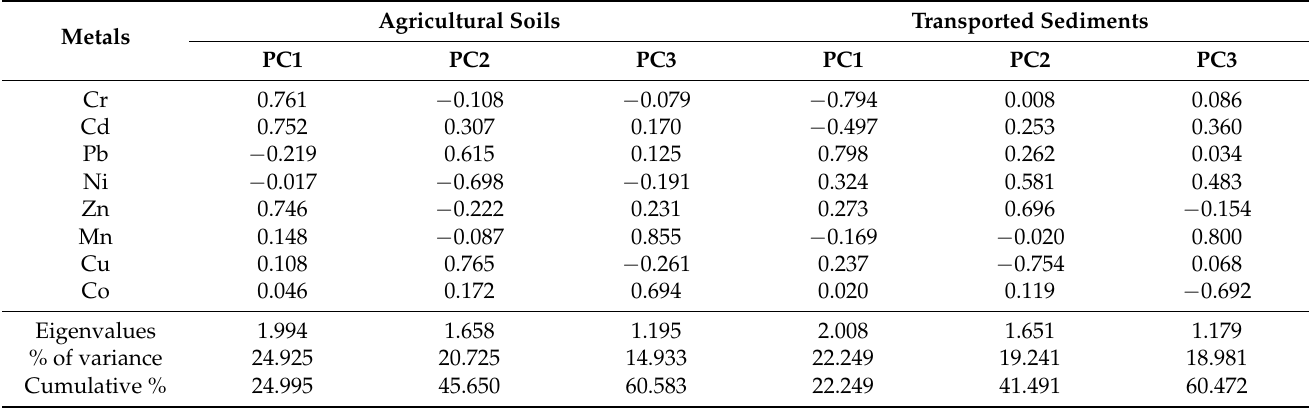
Table 6. Coefficients of correlation among metals and the three principal components.